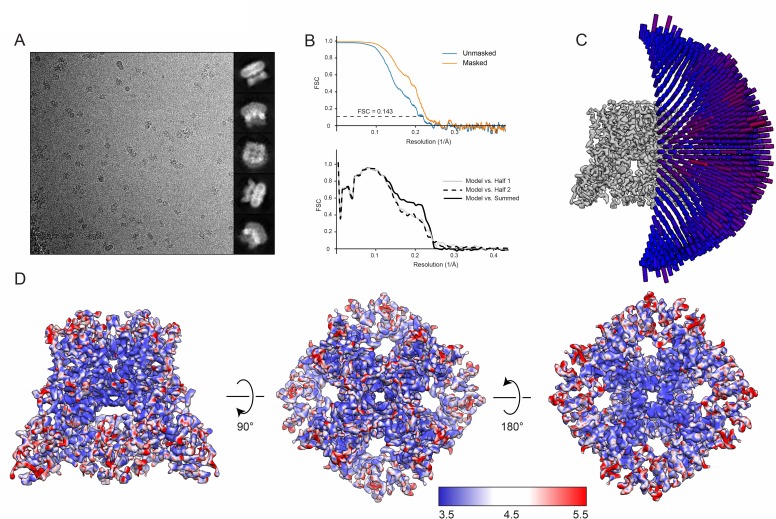
Cryo-EM overview of ZINC9155420-bound TRPV5 in nanodiscs.(A) (left) Representative 2D micrograph of rbTRPV5 incubated with 10 µM ZINC9155420 in nanodiscs. (right) 2D classes of ZINC9155420-bound TRPV5 in nanodiscs. (B) FSC curves and model validation curves of ZINC9155420-bound TRPV5 in nanodiscs. (C) Angular distribution of particles used to reconstruct the final 3D structure of ZINC9155420-bound TRPV5 in nanodiscs. Tall red cylinders indicate a larger number of particles and short blue cylinders indicate fewer particles. (D) Multiple views of the local resolution of ZINC9155420-bound TRPV5 in nanodiscs. Regions colored blue have local resolutions of 3.5 Å, white regions are 4.5 Å and red regions are 5.5 Å.